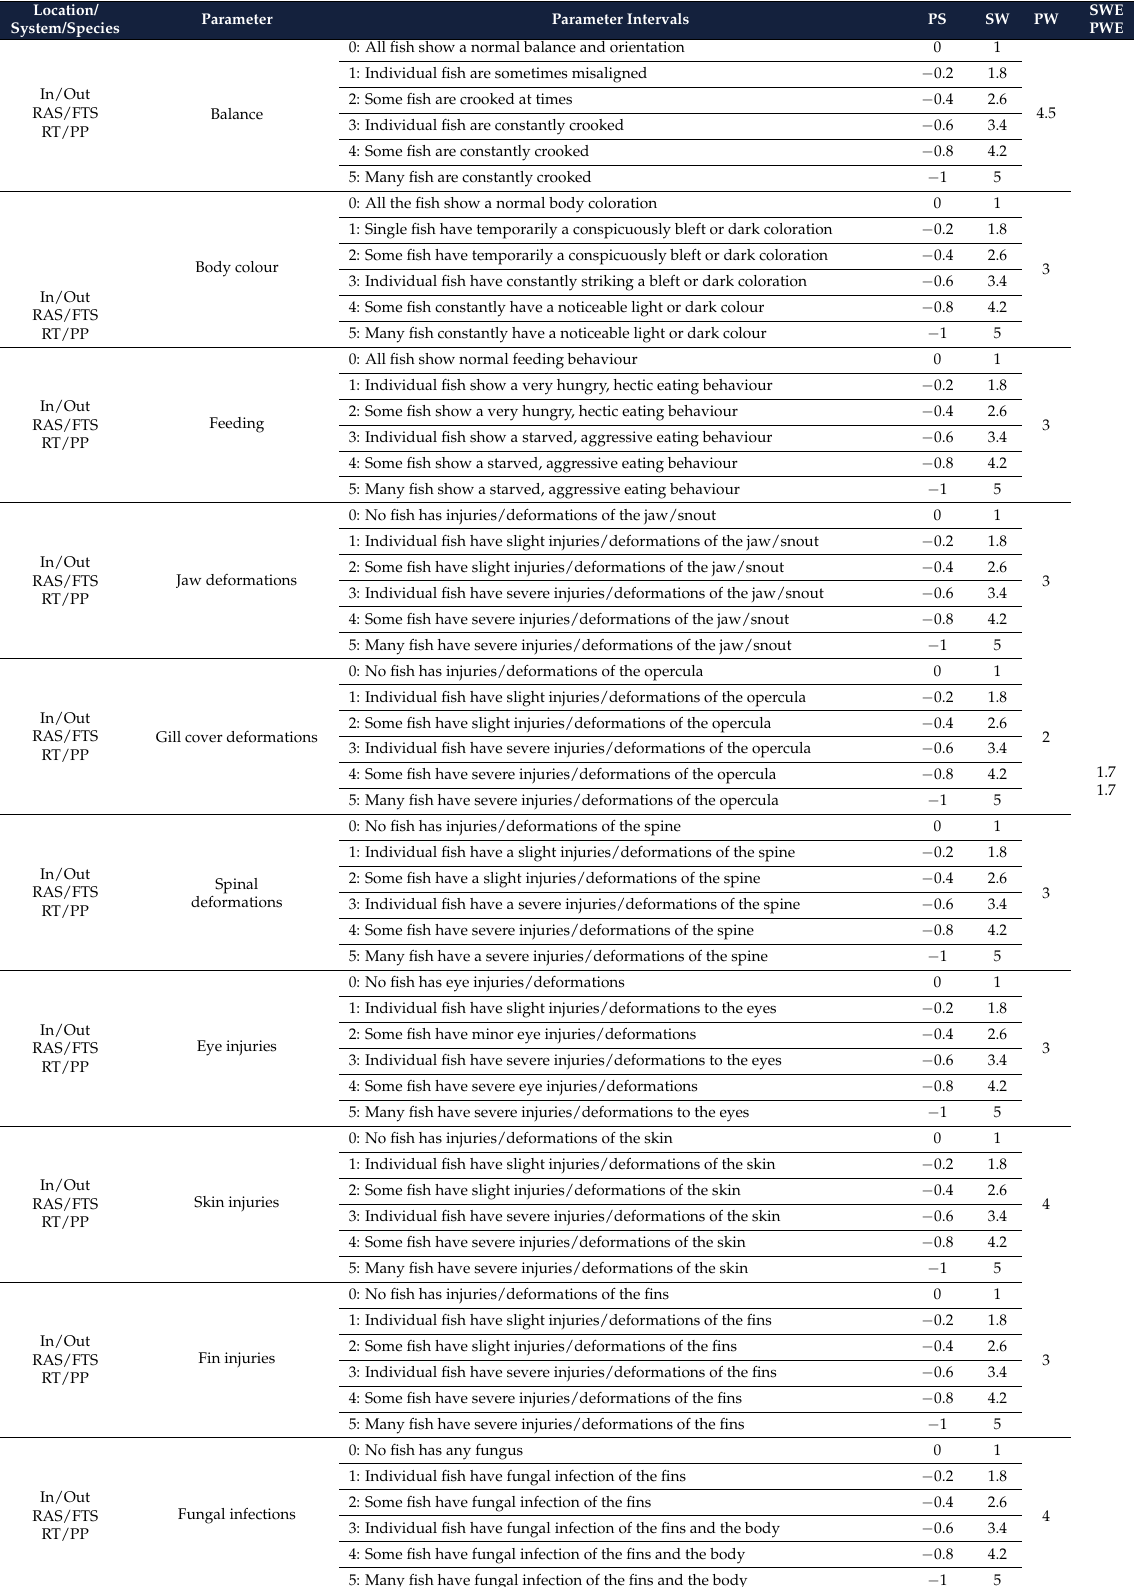
Table A4. Module fish group behaviour (2/2). In = indoor, Out = outdoor, RAS = recirculating aquaculture system, FTS = flow-through system, RT = rainbow trout, PP = pikeperch, PS = parameter score, SW = score weight, PW = parameter weight, SWE = score weight exponent, PWE = parameter weight